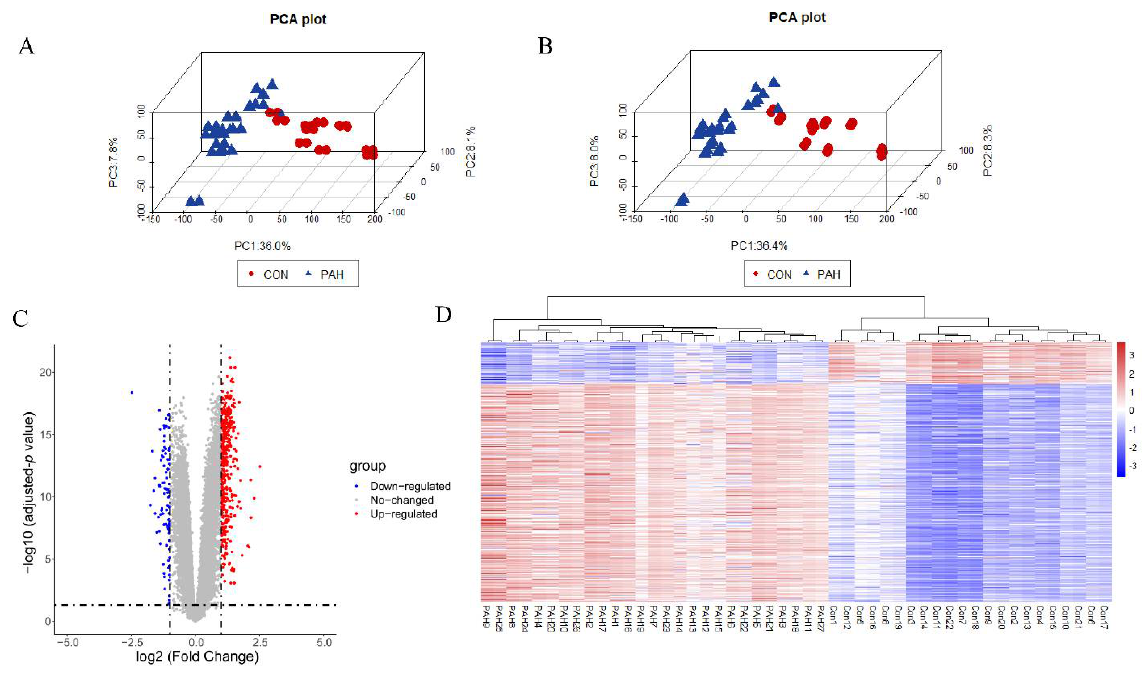
Figure 2. Datasets merging and DEG screening. ( A , B ) Three-dimensional PCA plots before and after the removal of inter-batch effect. ( C ) Volcano plot. ( D ) Heatmap of all DEGs. CON, normal lung tissue; PAH, lung tissues of pulmonary arterial hypertension patients; DEGs, differentially expressed genes.